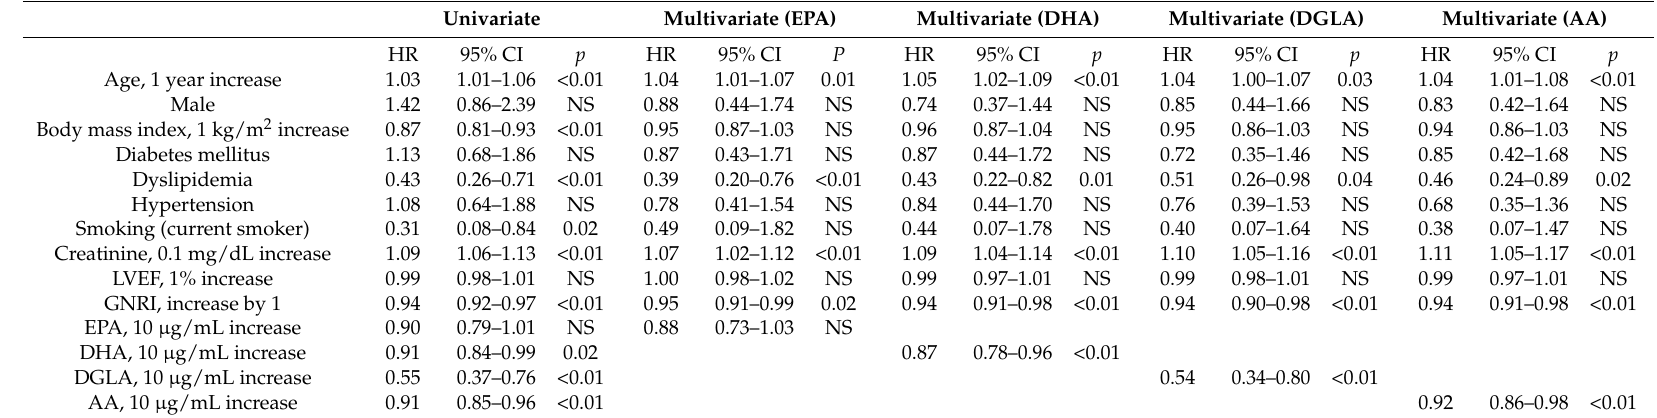
Table 2. Univariate and multivariate Cox regression analyses for all-cause